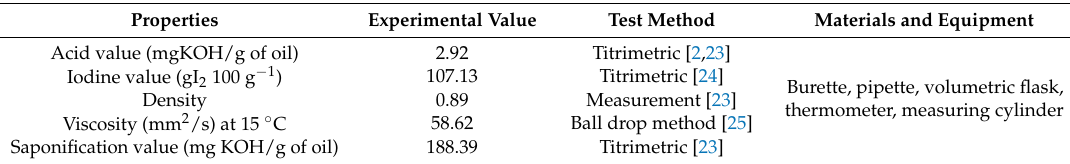
Table 1. Properties of waste cooking